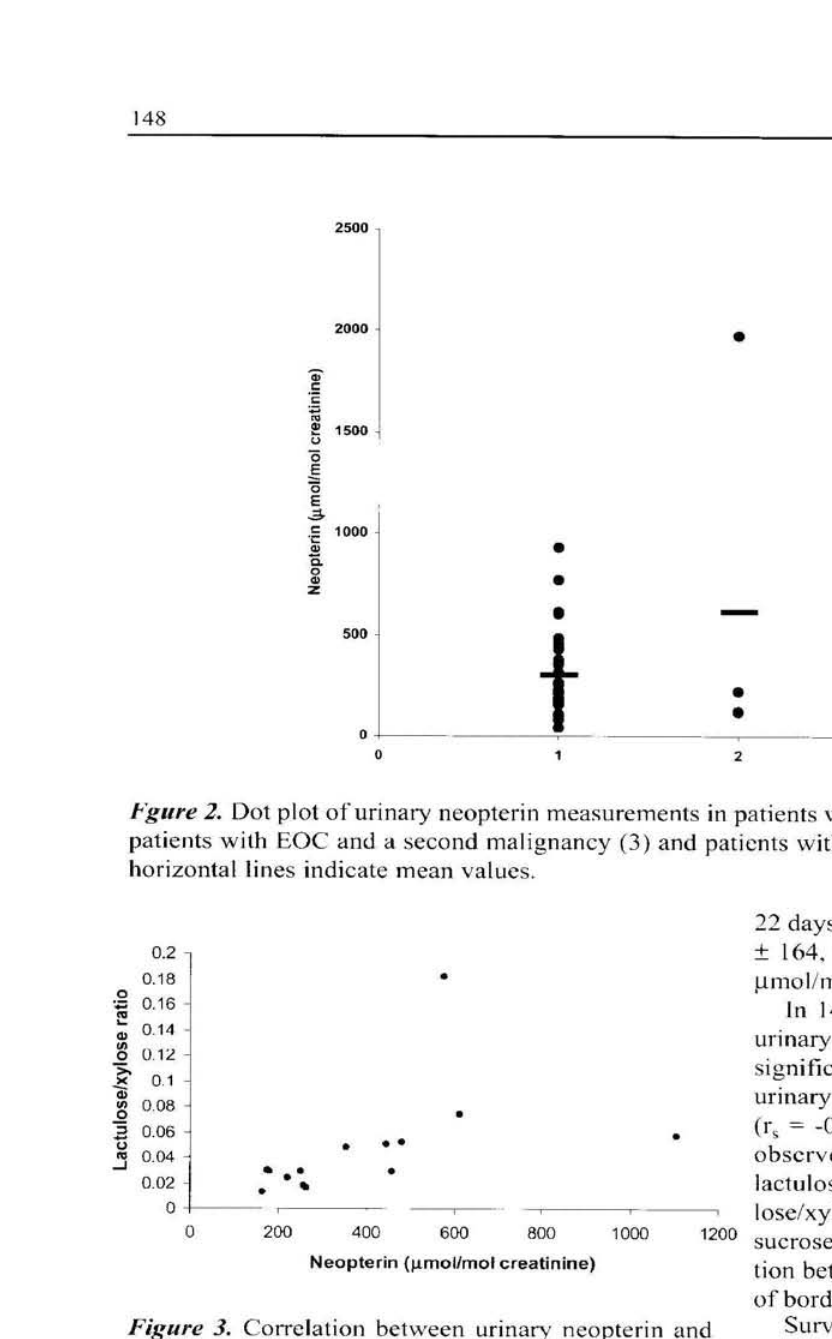
Figure 3. Correlation between urinary neopterin and lactulose/xylose ratio (r s = 0.79, ρ < 0.001 ). patients with urinary neopterin equal or above 338 μπιοΐ/ηιοί creatinine (mean of all patients) compared to 2 of 19 (11%) of patients with urinary neopterin below 338 μιηοΐ/mol creatinine (Fisher exact test, ρ - 0.001). Twenty patients were evaluated before and dur- ing the therapy with paclitaxel/platinum combination chemotherapy. Compared to pretreatment neopterin (268 ± 197, range 41 - 930 μιηοΐ/mol creatinine), no significant changes were observed in urinary neopterin Pteridines/Vol. 17/No.